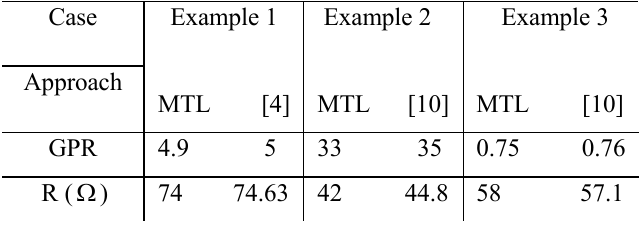
Table 1. Comparison of GPRs and of grounding grids